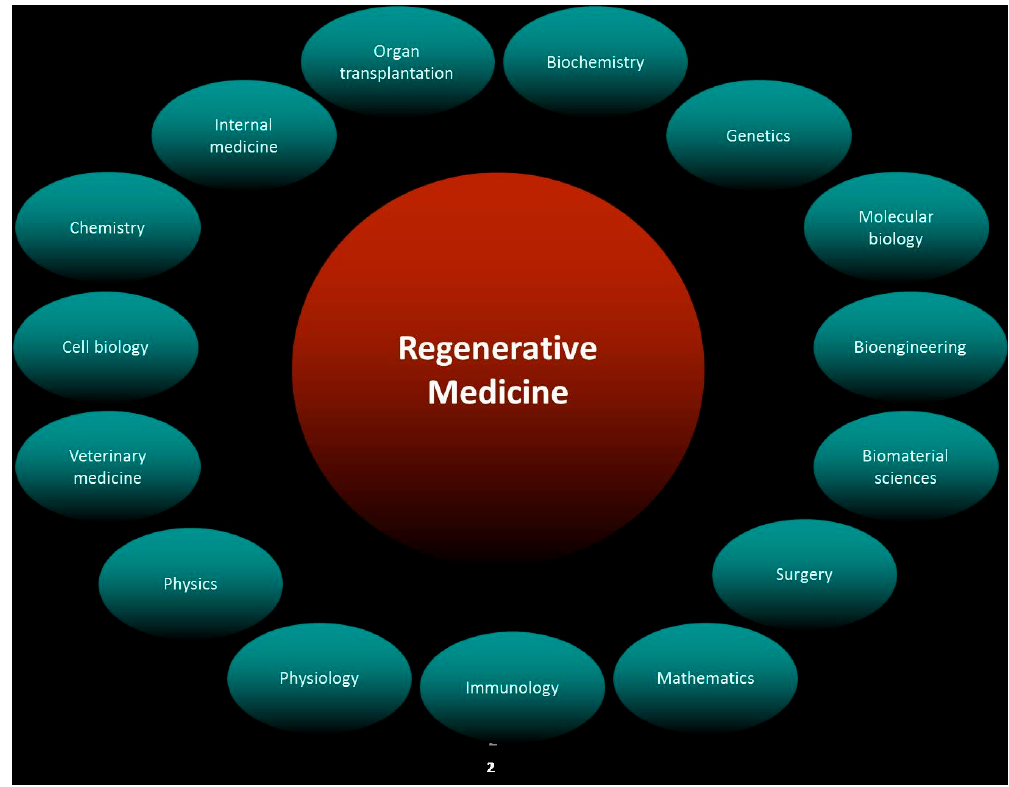
Figure A1. Regenerative medicine is a discipline with contours still being defined. By nature, it